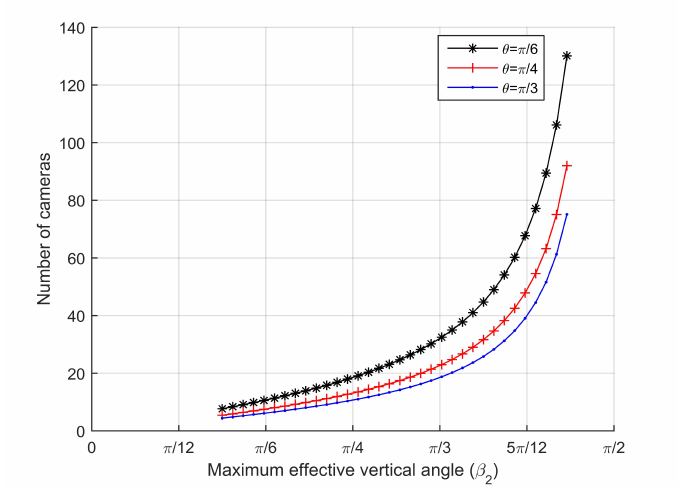
Figure 8. Number of camera sensors per 100 m vs. maximum effective vertical angle for different horizontal one-half angle of